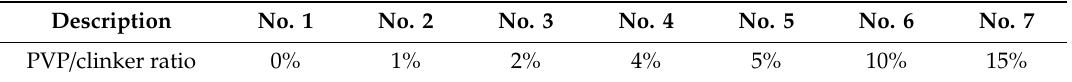
Table 2. Proportion used for preparation of coating film.